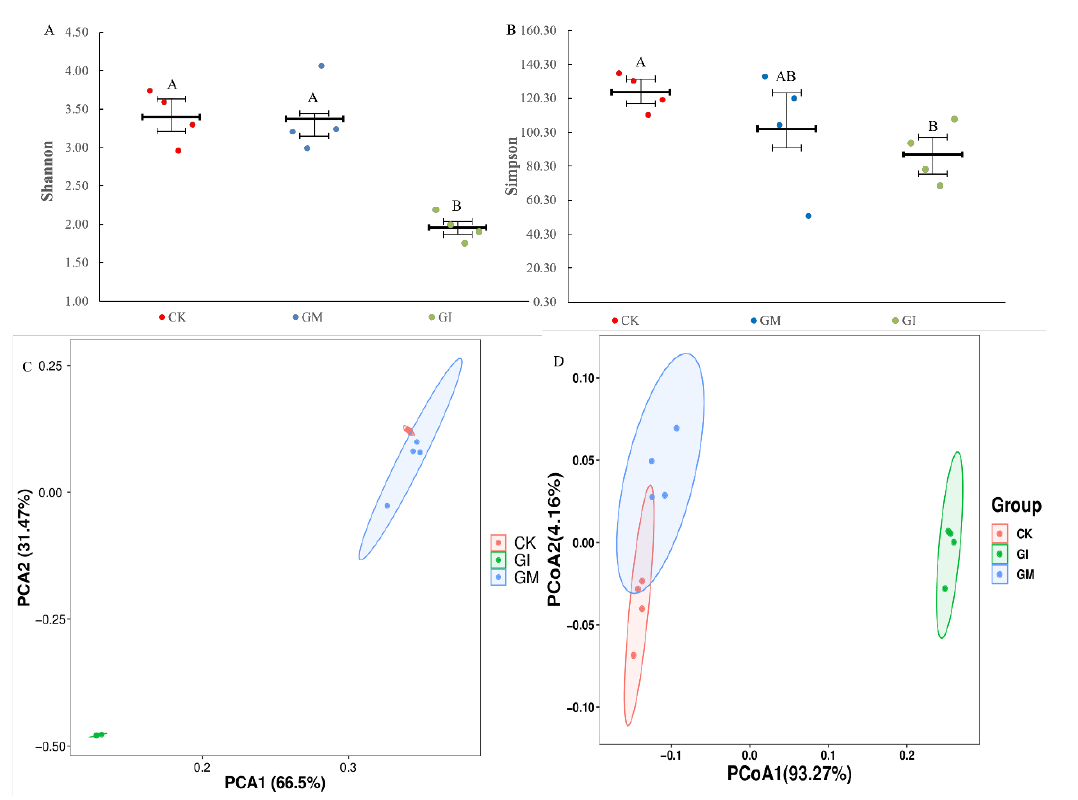
Figure 2. The gut microbial diversity in the gypsy moth larvae at the 5th instar after rearing on the leaves of GM, GI, or n nonmycorrhizal-colonized plants. ( A ): Shannon index. ( B ): Simpson index. ( C ): Principal component analysis (PCA). ( D ): PCoA plot of the gut microbiota structures based on the unweighted UniFrac analysis. Different capital letters indicate significant differences between treatment groups or control group ( p < 0.05).